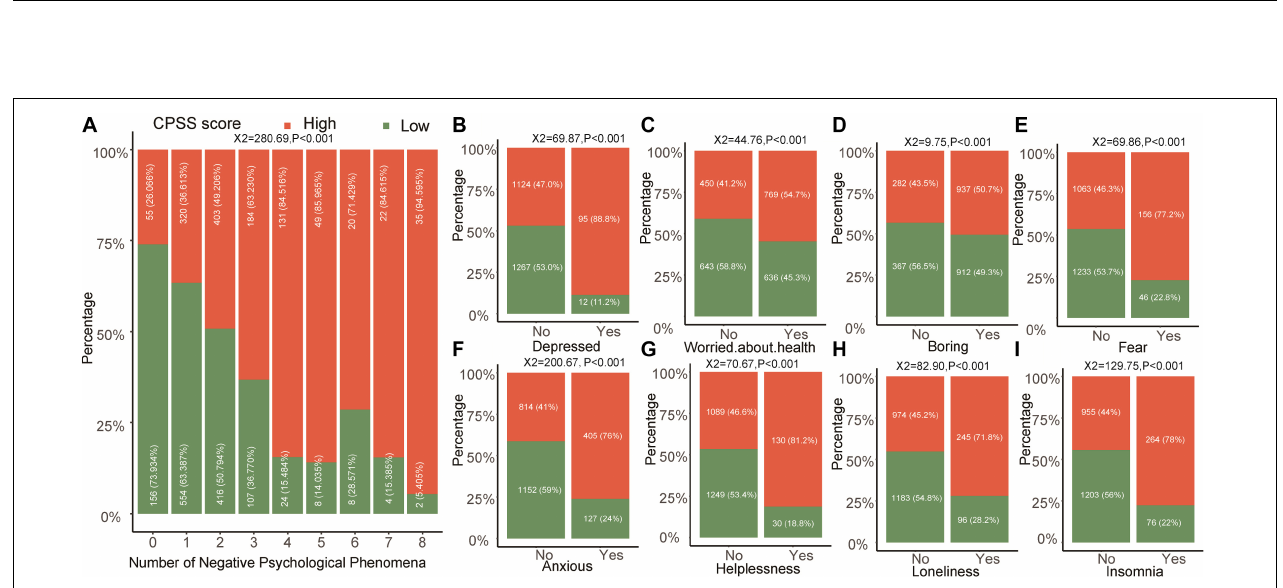
FIGURE 5 | The relationship between CPSS score with different negative psychological phenomena in medical students. (A) The trend of the number of negative psychological phenomena in high or low CPSS score groups. (B–I) The individual negative psychological phenomenon.